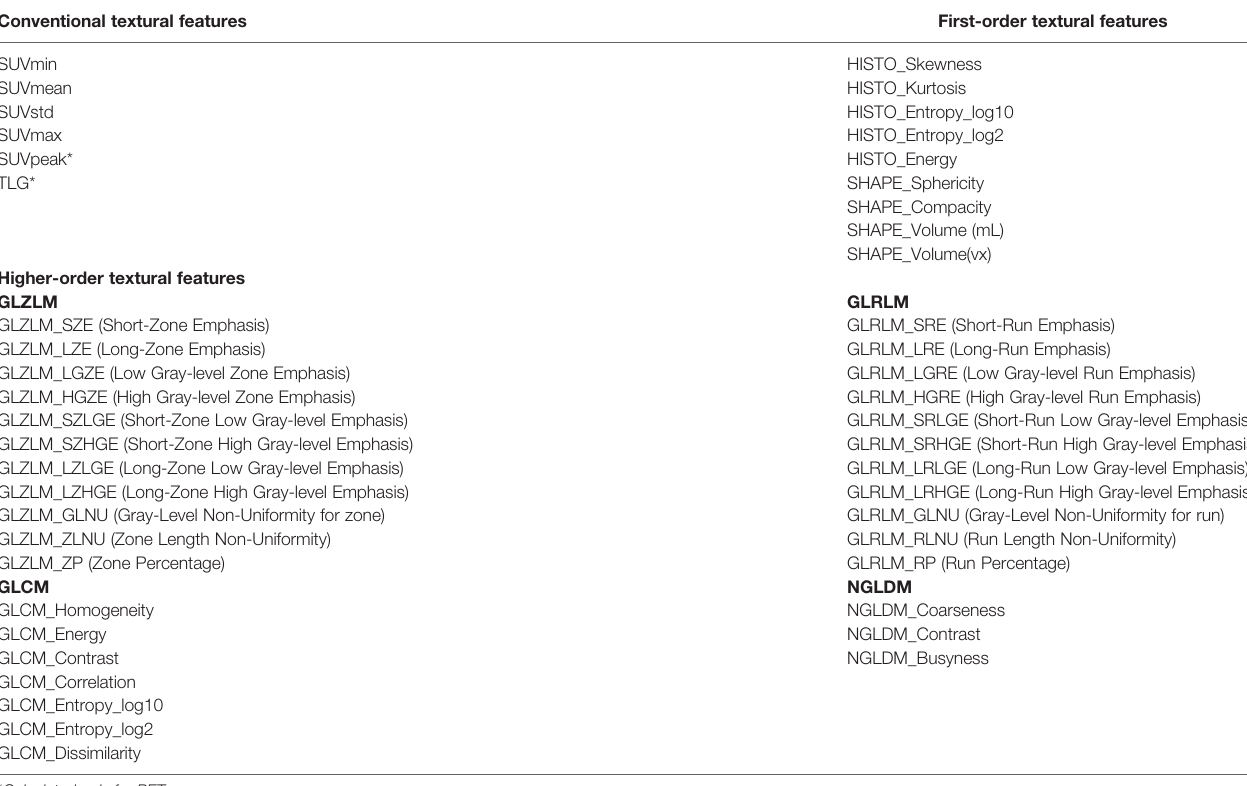
TABLE 3 | Radiomic